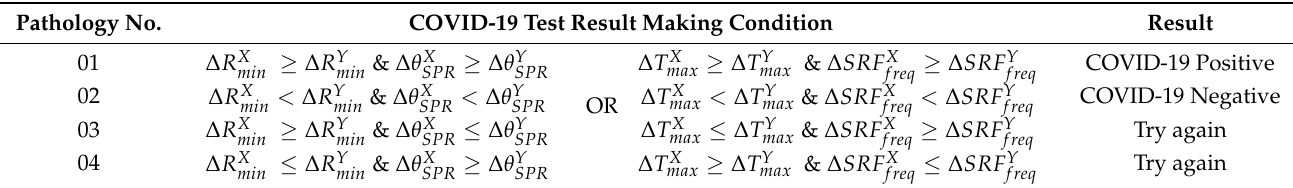
Table 9. COVID-19 test results based on the detection of attributors’ characteristics. Pathology No. COVID-19 Test Result Making Condition